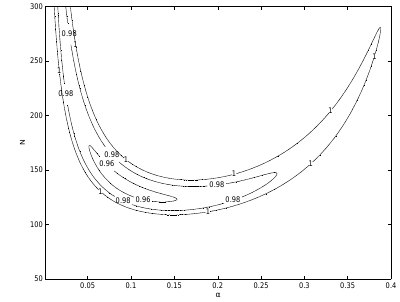
Figure 13. Contour plots of q T ( α, N,m ) given by ( 3.1) and q R, 1 ( α,N,m,r 0 ) given by (3.3) for r 0 = 0 . 1 and m = 6 .